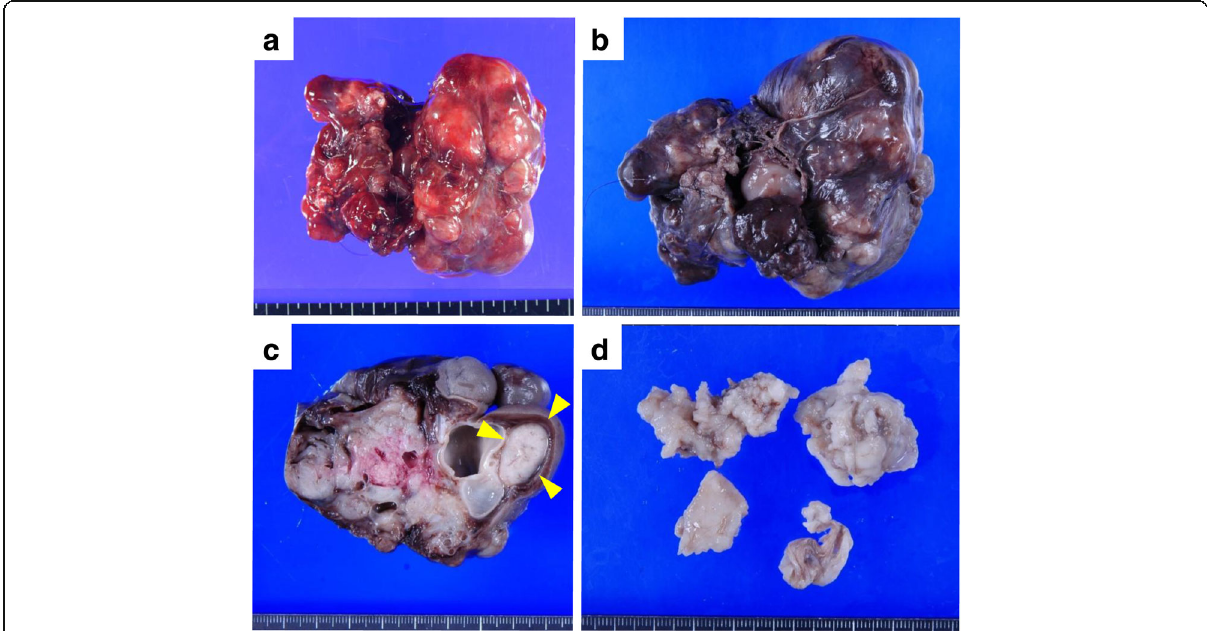
Fig. 3 Macroscopic images of the epignathus. a At autopsy, the epignathus is a large reddish multicystic tumor. b After formalin fixation, the epignathus is seen as a dark-brown-colored tumor and cysts containing serous or bloody fluids. c The cut section shows whitish solid parts and cysts. A small component resembling a lung is seen (arrowhead). d The intracranial tumor is white and